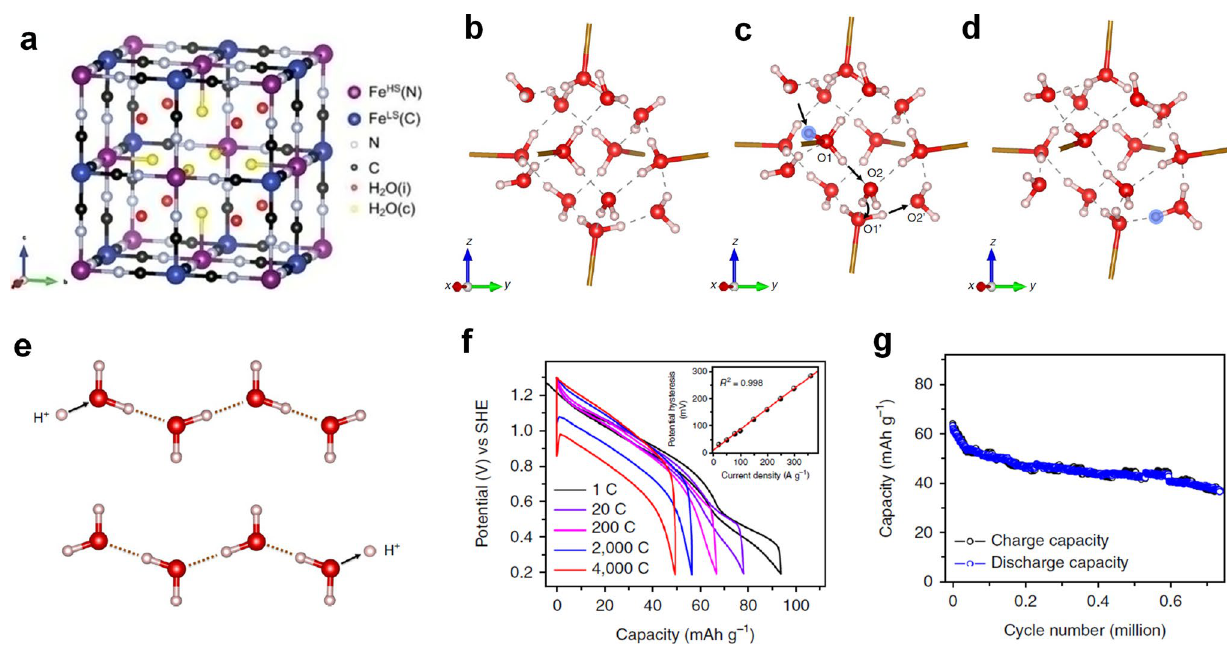
Fig. 5 a Schematic of crystal structure of Fe 4 [Fe(CN) 6 ] 3 ·14H 2 O [68]. Copyright 2020, Wiley–VCH. b – d The transport path of protons in CuFe- TBA. e Schematic of Grotthuss mechanism. f GCD curves of CuFe-TBA at different current rates. g Cycle performance of CuFe-TBA at a cur- rent density of 500 C [21]. Copyright 2019, Springer